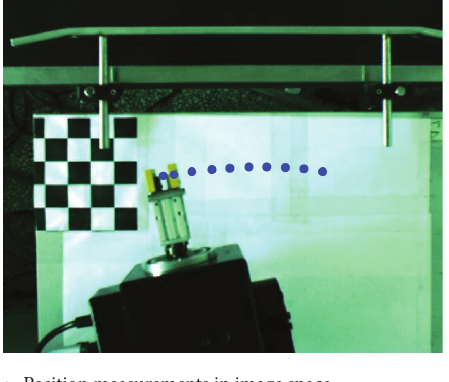
Figure 11: The trajectories of end effector in image space.